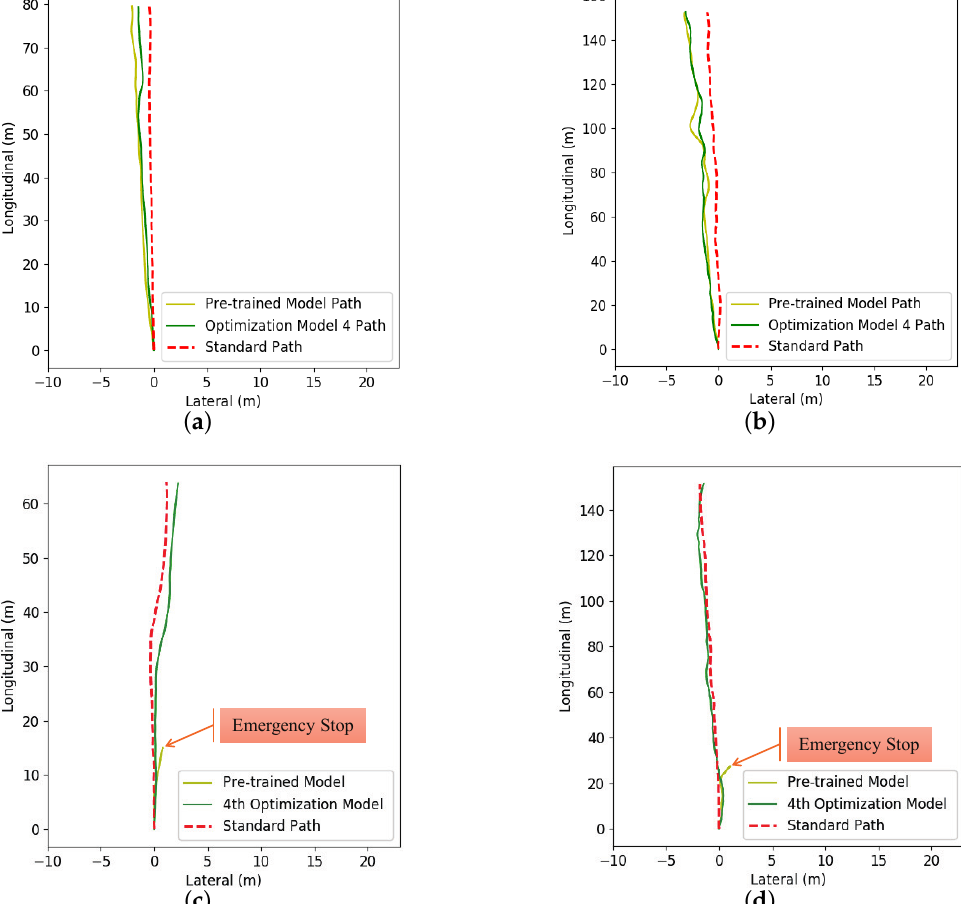
Figure 14. ( a , b ) are the paths of vehicle driving on A → B section and B → C section, ( c , d ) are the paths of the vehicle driving on C → D section and D → A